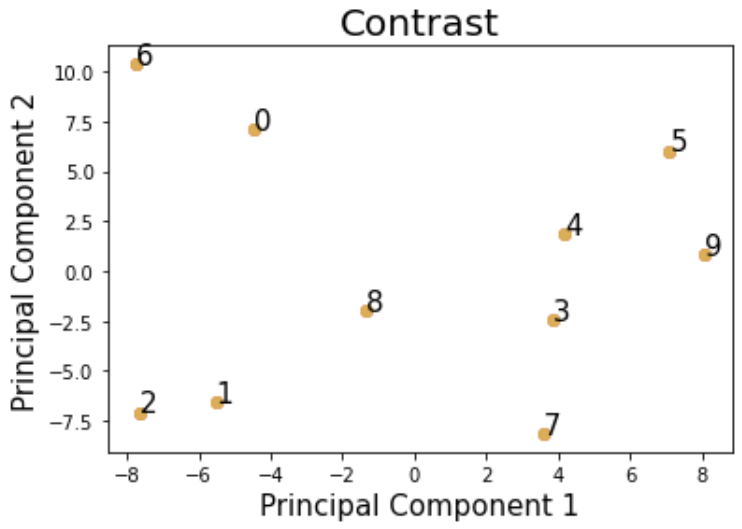
Figure 13. Two-dimensional principal component analysis projection of AWGN+Contrast